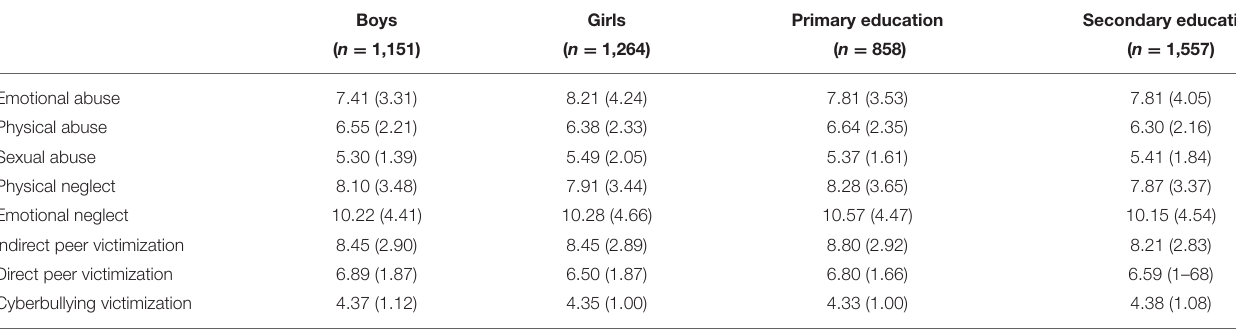
TABLE 1 | Child abuse and neglect and peer victimization scores by sex and educational